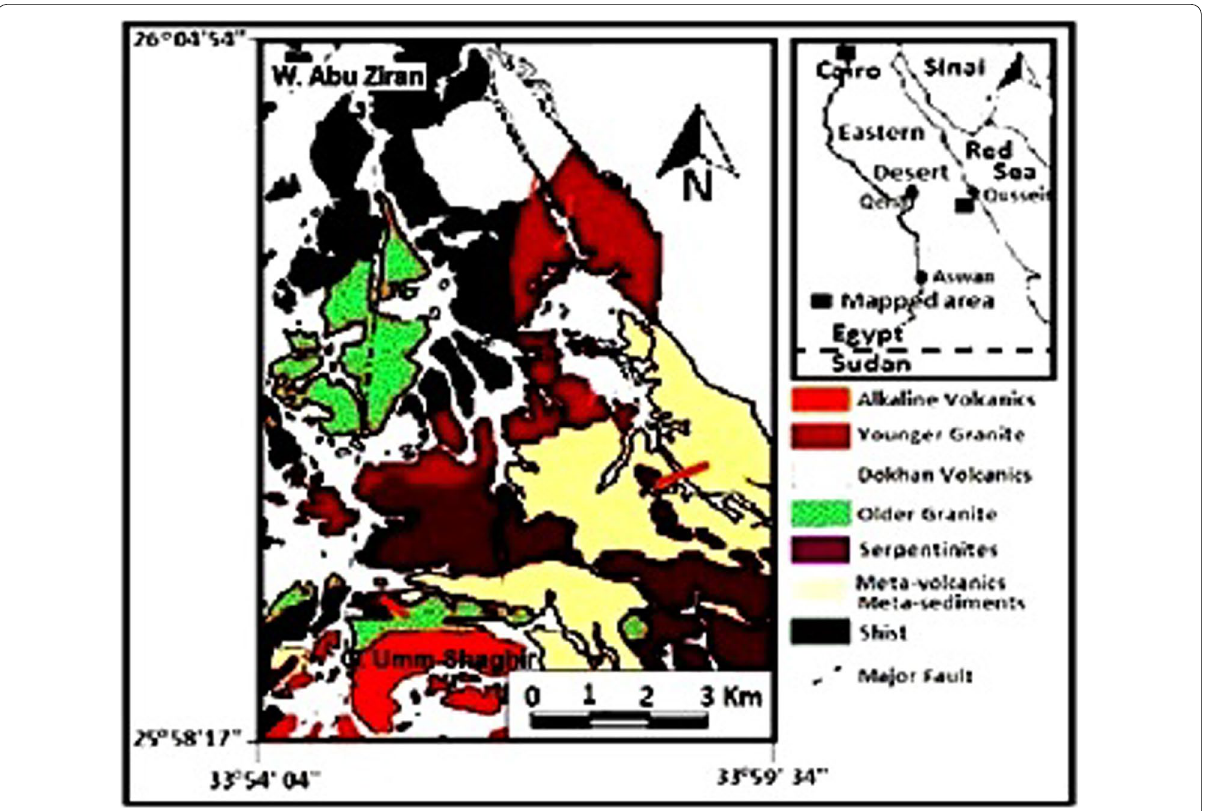
Fig. 1 Geological map of Umm Shaghir Area, (after Shalaby et al. (2019))